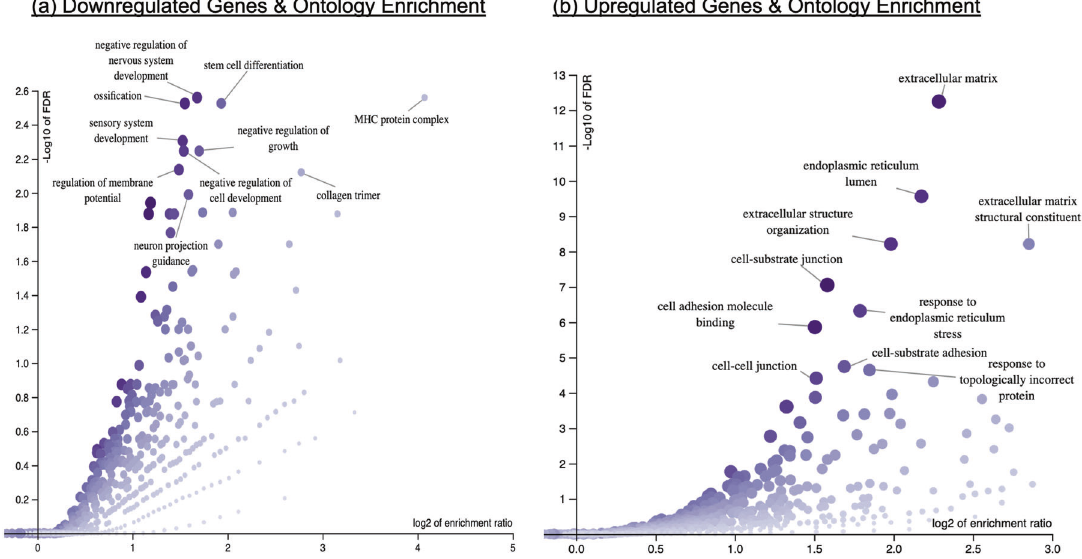
Fig. 4 Volcano plots illustrating signi fi cantly enriched gene ontology terms in response to high-dose lithium. a GO terms signi fi cantly downregulated in response to high-dose lithium, ( b ) GO terms signi fi cantly upregulated in response to high-dose matrix, and endoplasmic reticulum, Fig. 4. Whilst the effect of lose full results. The 327 genes downregulated in our model were dose lithium on gene expression was more subtle, approximately enriched for GO terms related to nervous system development one-third of the genes nominally affected by this dose ( P < 0.05), and the MHC protein complex. The 383 upregulated genes were were also affected by the high-dose condition ( P FDR < 0.05; 78 out enriched for GO terms related to cell adhesion, the extracellular